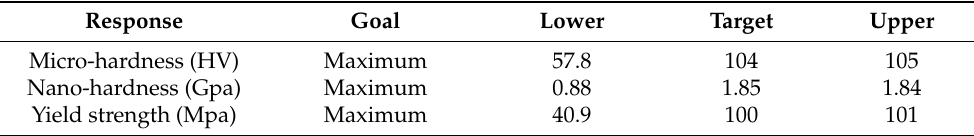
Table 4 outlines the conditions used for optimization in the developed fuzzy logic model. According to the fuzzy logic model, the optimum condition (i.e., the highest strength) can be reached at the coded values of rotational speed, traverse speed, and axial force of − 1.2, 1.5, and − 0.46, respectively. This means that the highest strength can be obtained using a tool rotational speed of 560 rpm, a tool traverse speed of 175 mm/min, and a tool axial force of 2.27 kN. Table 4. The used condition for optimization of